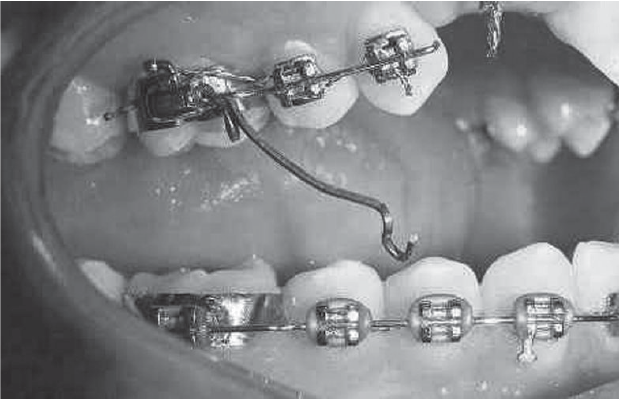
Fig. 8: Lateral photograph of cantilever activation.